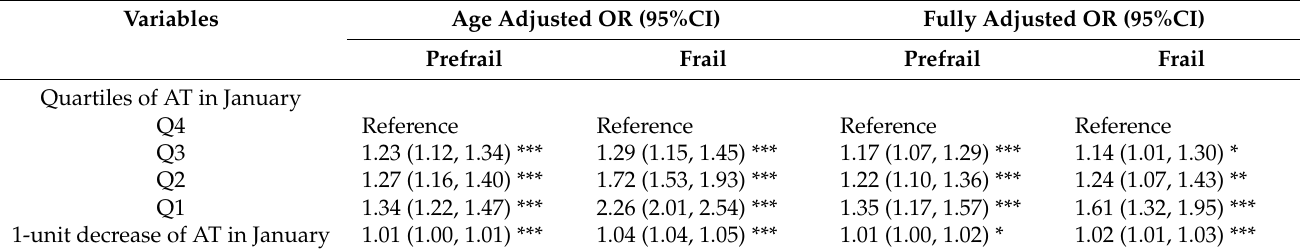
Table 2. GLMM analysis for the associations between average temperature in January and frailty.